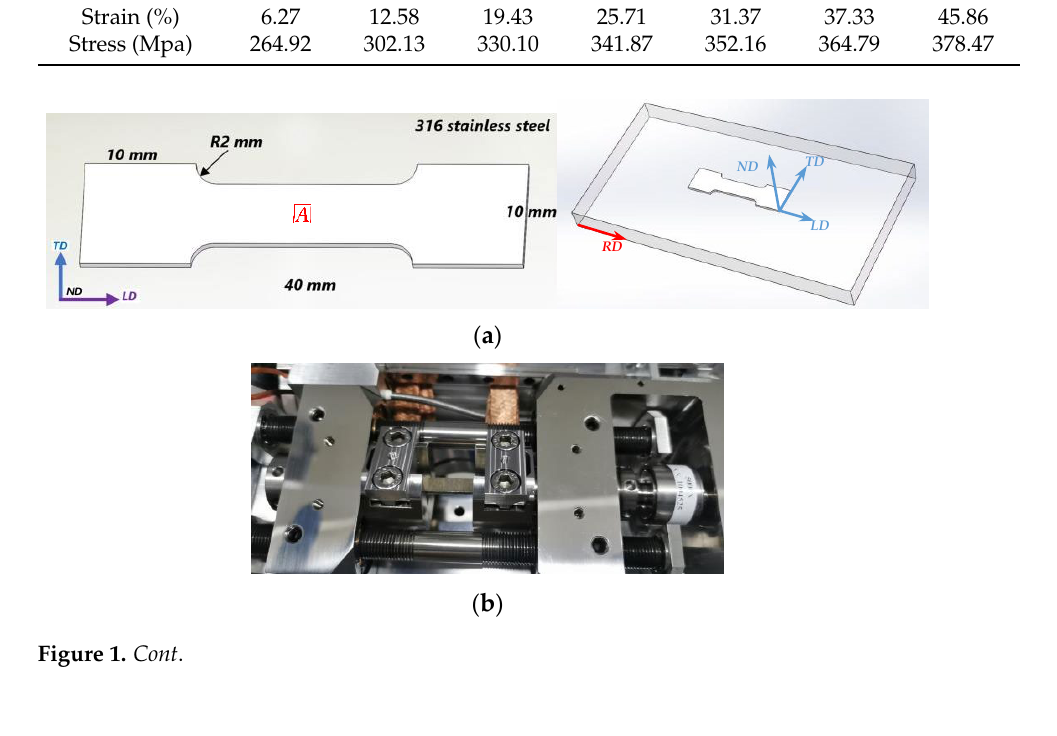
Table 1. Stress–strain data of the 316 stainless steel corresponds to each stretch point. Stretch Point